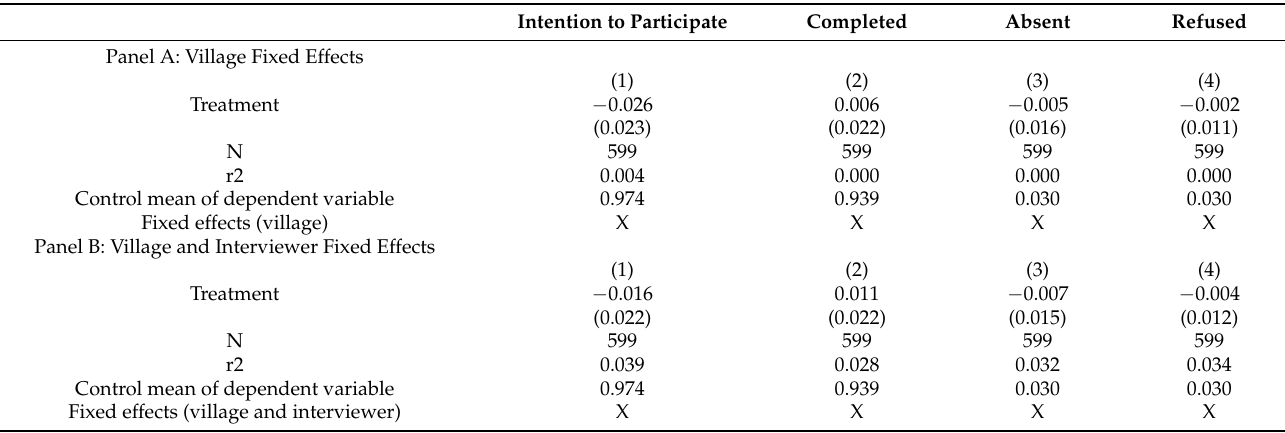
Table 3. Status of follow-up